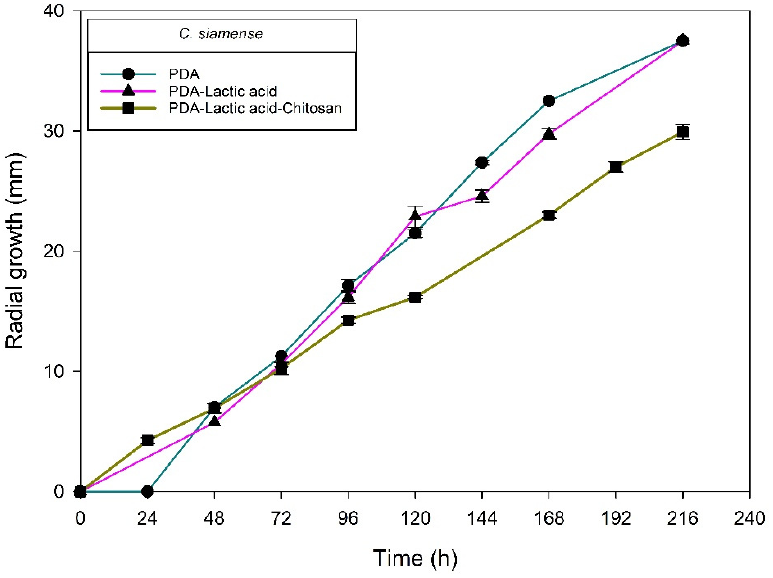
Figure 5. Colletotrichum siamense isolated (H6-1) from anthracnose of mango. Kinetics of radial growth (mm) in medium PDA, PDA-lactic acid (0.05 M), and PDA-lactic acid (0.05 M) with 1 g L − 1 chitosan at 25 °C.